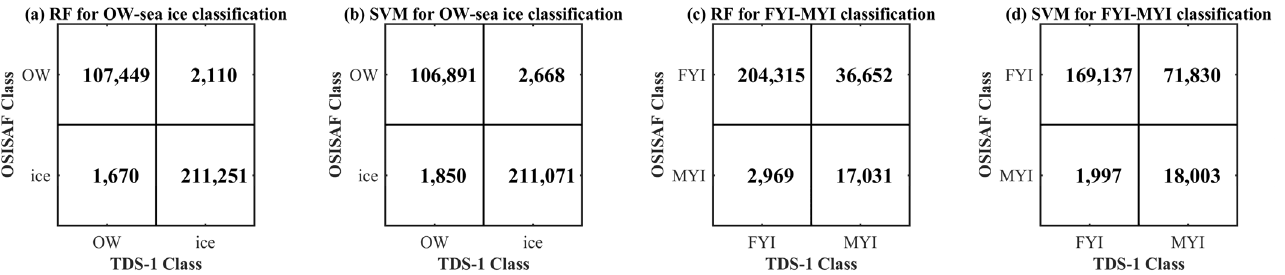
Figure 11. Confusion matrix of ( a ) random forest (RF) and ( b ) support vector machine (SVM) for open water (OW)-sea ice classification. Confusion matrix of ( c ) RF and ( d ) SVM for first-year ice (FYI)-multi-year ice (MYI) classification.